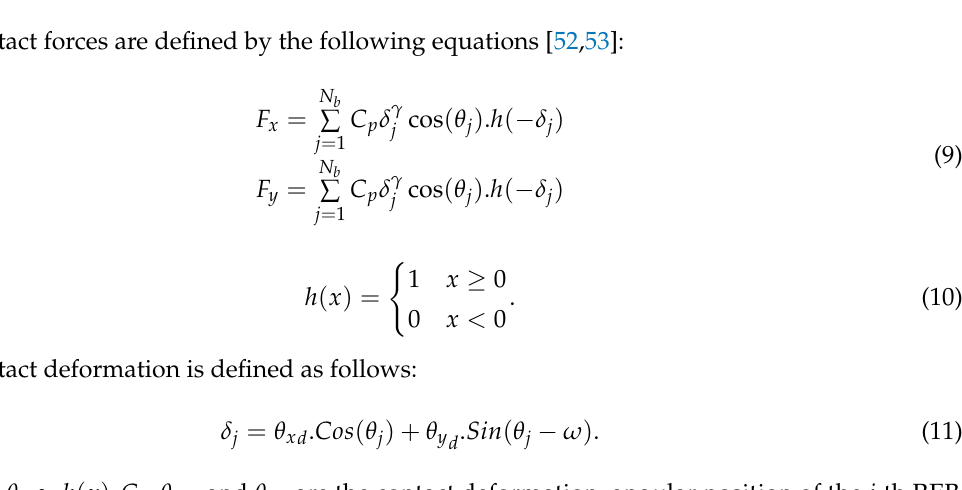
Figure 3. Five degrees of freedom of the rolling element bearing (REB)